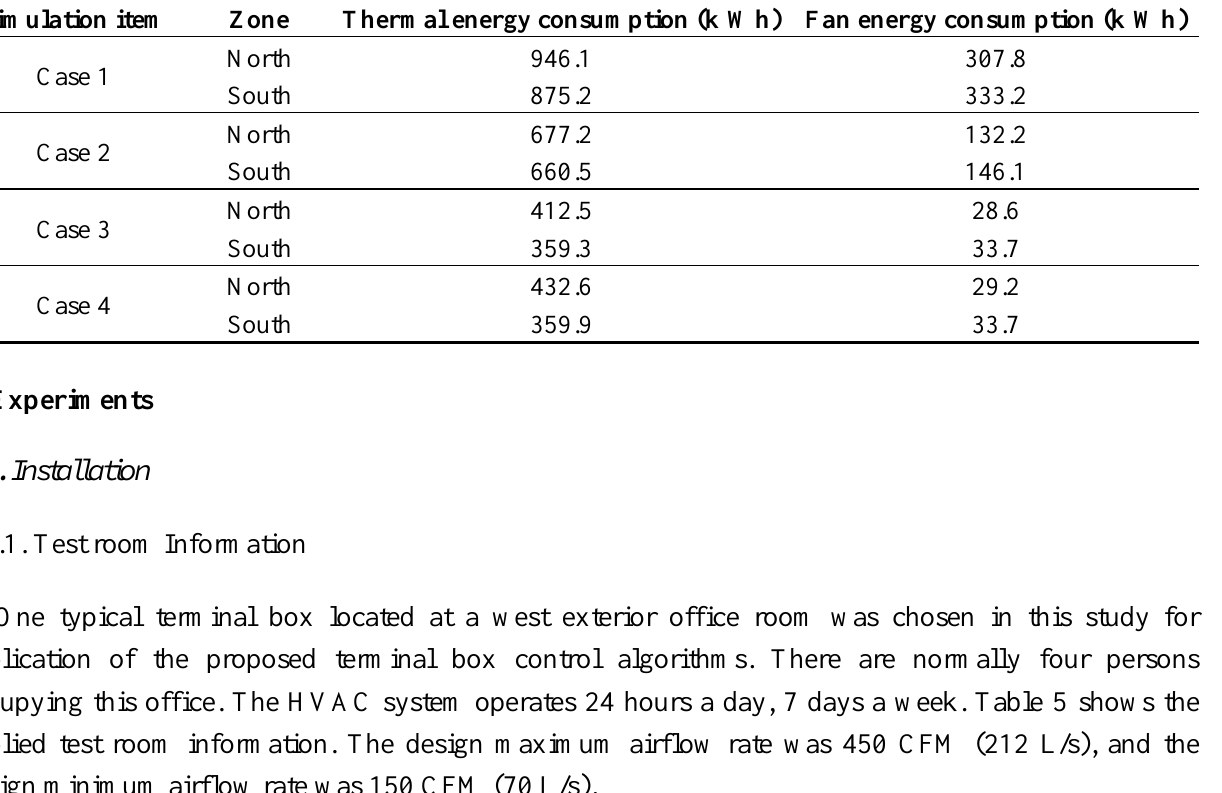
Table 4. Simulation results of energy consumption.